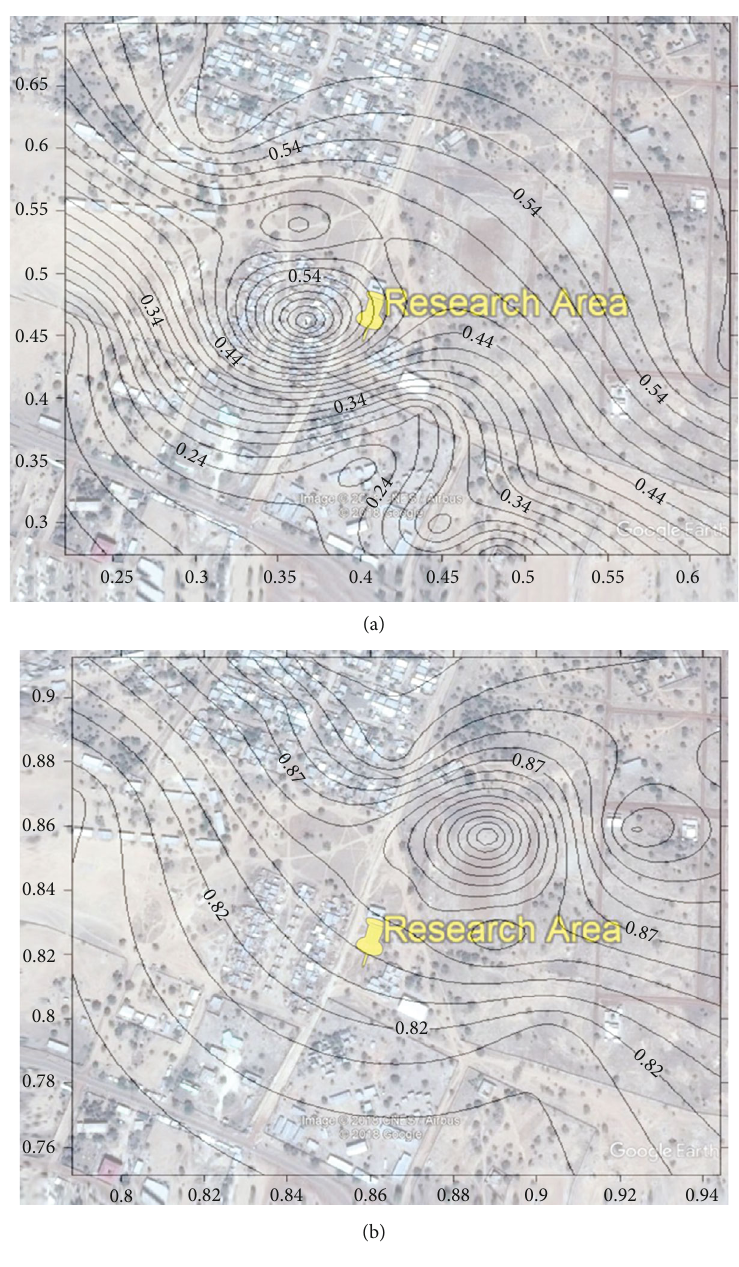
Figure 2: Aerosol distribution over the same community